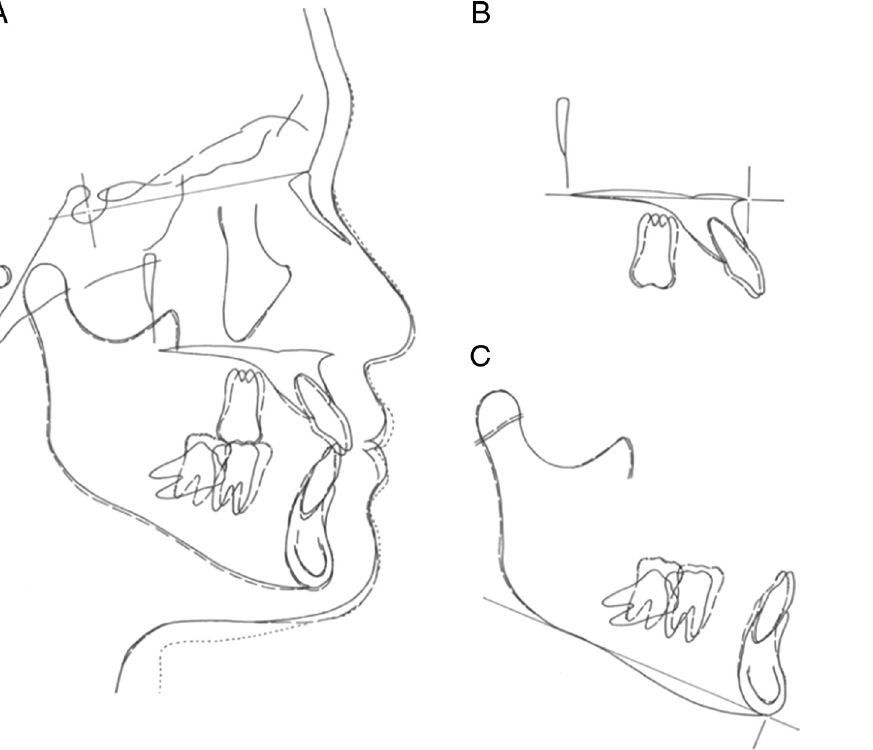
Figure 6. Superimposed tracings of lateral cephalometric radiographs at pretreatment (solid line), posttreatment (dashed line), and after retention (dotted line); right molars are traced. (A) on the sella-nasion plane at the sella, (B) on the palatal plane at ANS and (C) on the mandibular plane at